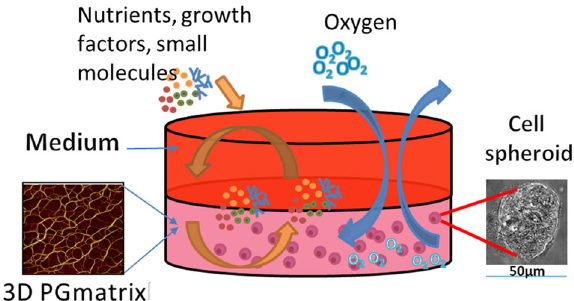
Fig. 1 PGmatrix 3D scaffolding provides in vivo like microenvir- onment for cells, allows free-diffusion of nutrients, growth factors, small molecules, drugs and antioxidants (i.e, anthocya- nins), and serves as an oxygen buffer. Sample image of cell spheroids physiologically formed in 3D PGmatrix